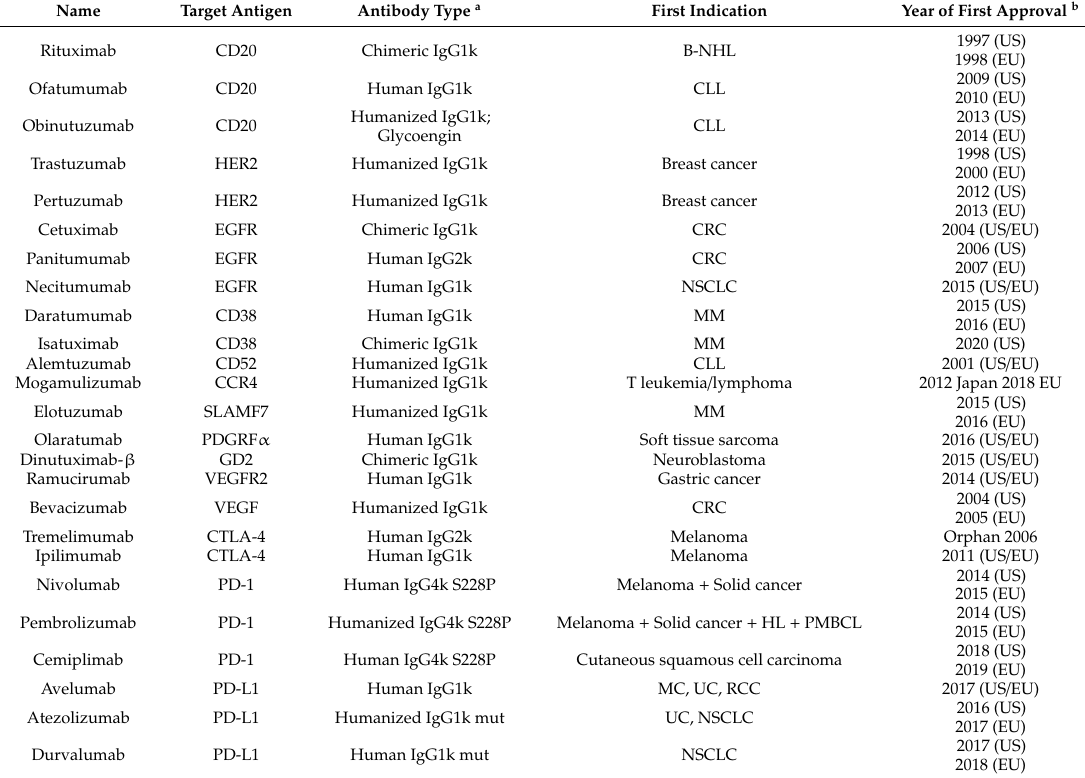
Table 2. Approved unconjugated anti-cancer MAbs (as of 1 May